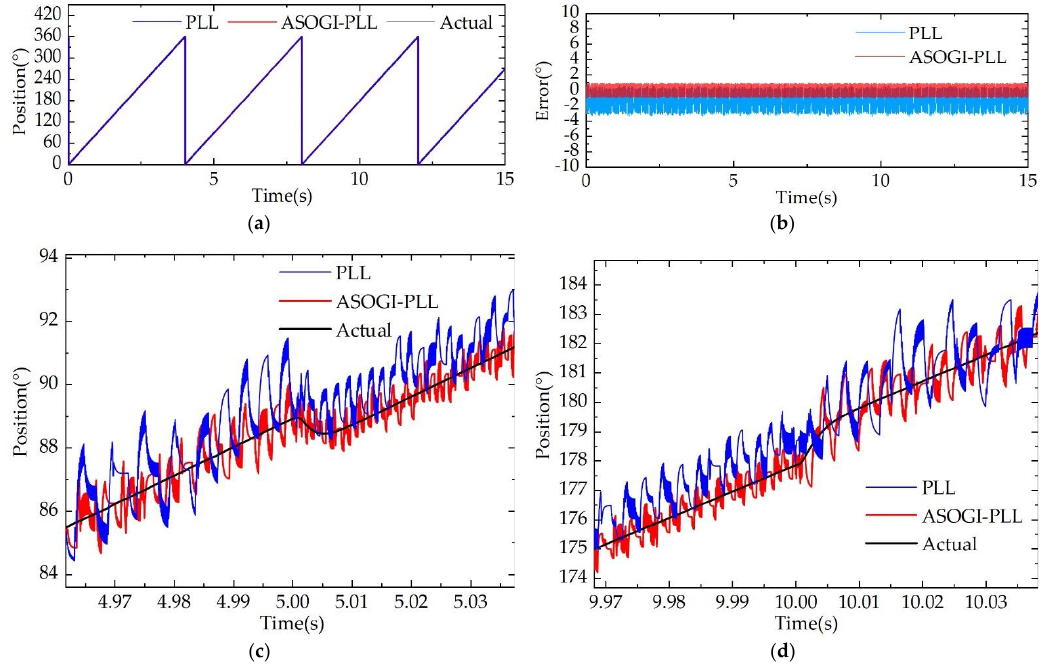
Figure 17. Sudden load change: ( a ) Rotor position waveform; ( b ) Rotor position estimation error waveform; ( c ) Rotor position local enlarged waveform at t = 5 s; ( d ) Rotor position local enlarged waveform at t = 10 s.